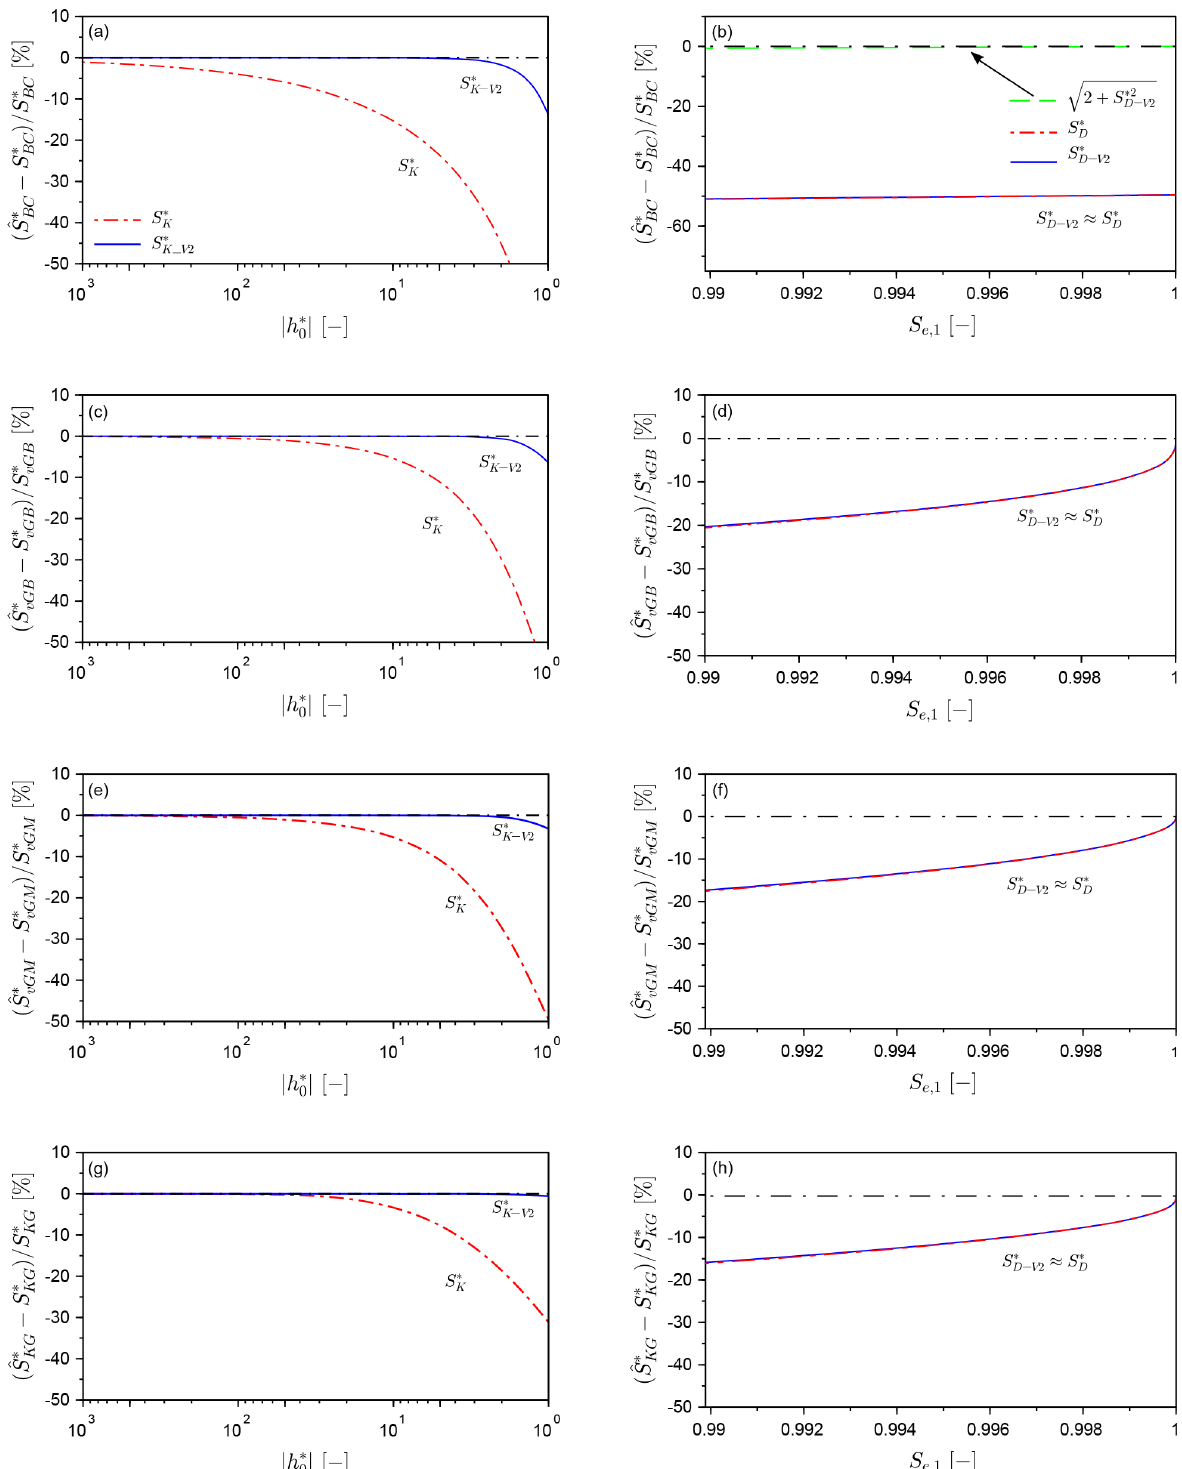
( 0 ,S e , 1 ) and S ∗ ( 0 ,S e , 1 ) (b, d, f, h) and S ∗ (h ∗ , 0 ) and S ∗ (h ∗ , 0 ) (a, c, e, g) D K 0 K-V2 0 D-V2